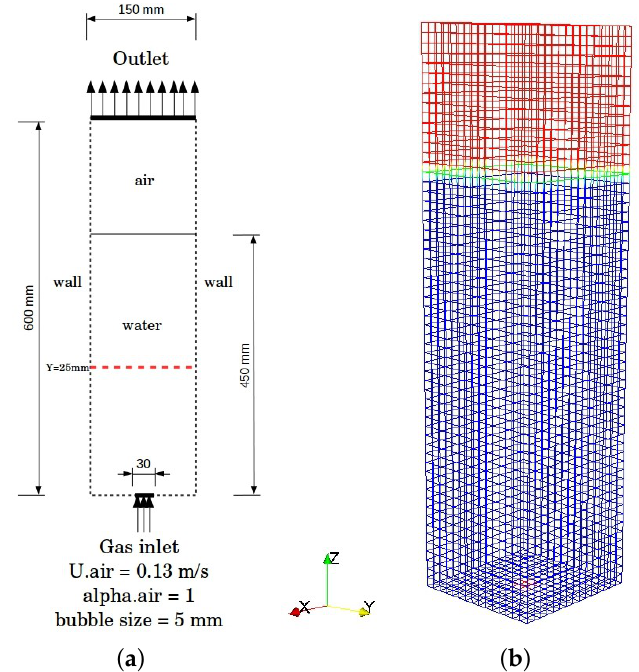
Figure 5. ( a ) Dimension and boundary condition in the bubble column (Deen [64]) and ( b ) the mesh (13,500 cells) in the case of Deen